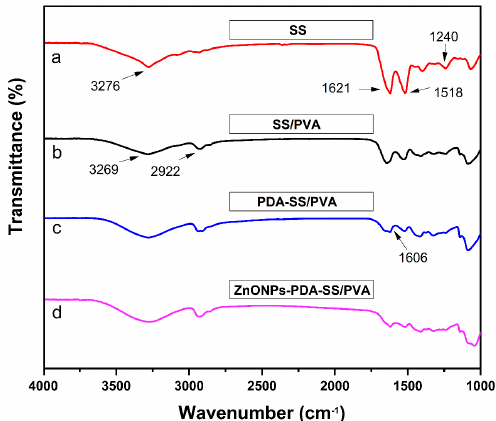
Figure 4. FT-IR spectra of the as prepared sericin and composite films ( a – d ).